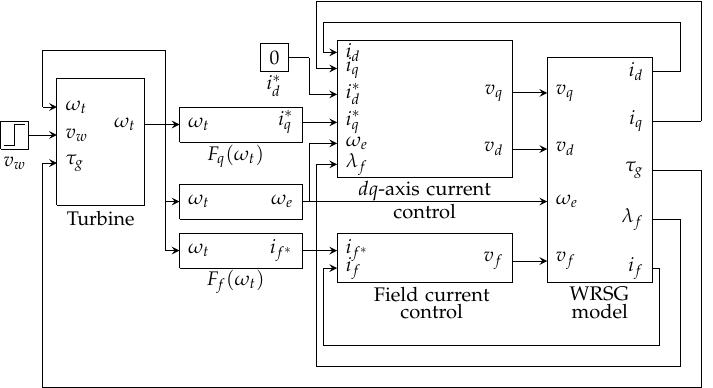
Figure 6. Matlab/Simulink block diagram of a variable-speed WRSG-based wind turbine system.